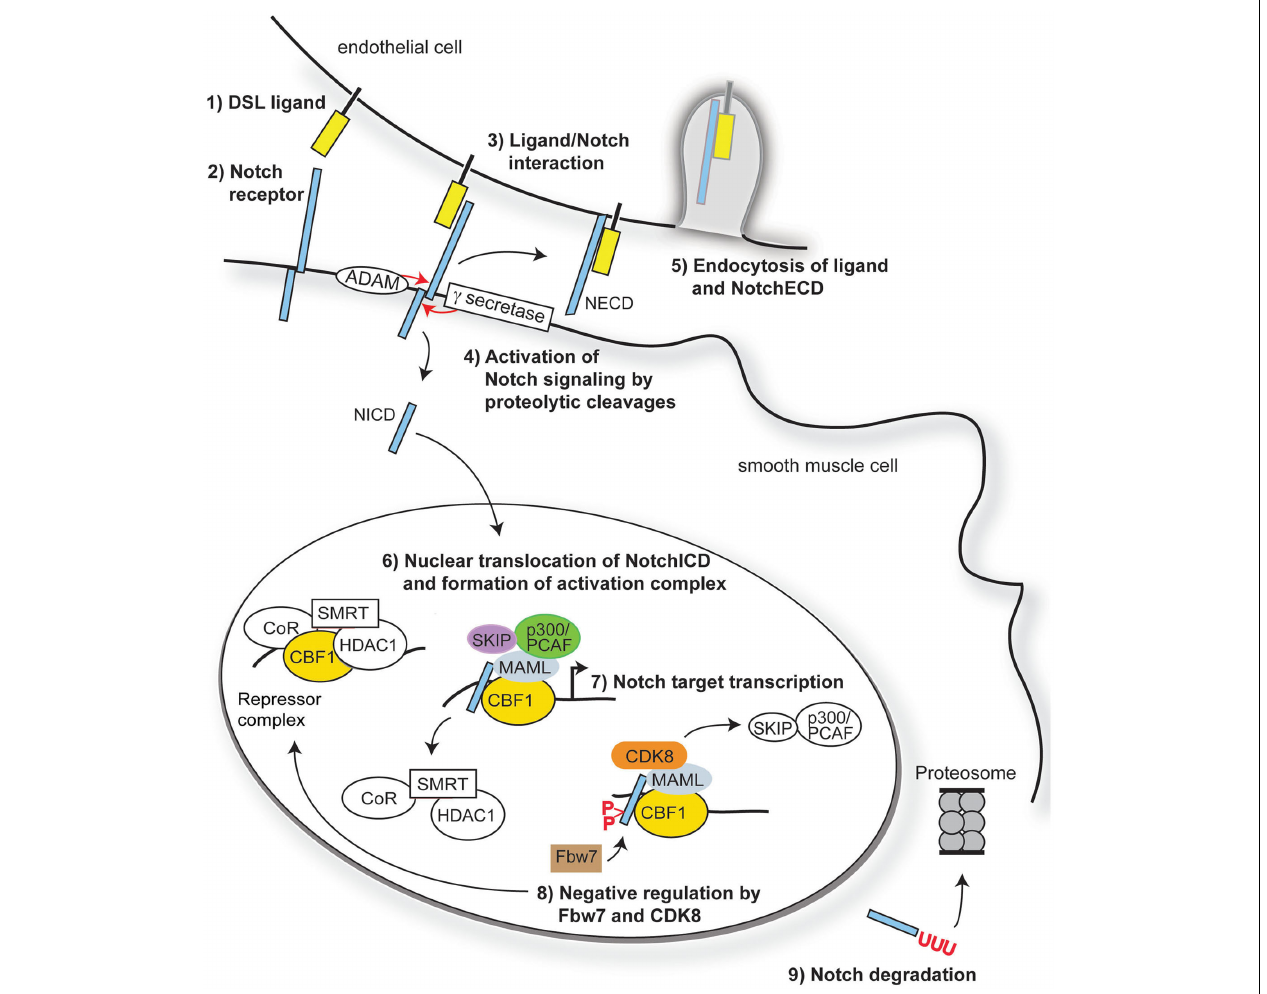
repressor CBF1, causing displacement of associated co-repressors and recruitment of Mastermind-like (MAML) and other co-activators (6) to initiate transcription of Notch/CBF1 regulated downstream genes (7).Turning off Notch signaling begins with recruitment of CDK8 by MAML to the active complex, thereby causing phosphorylation of NotchICD within its PEST domain. Phosphorylation causes recruitment of E3 ubiquitin ligase Fbw7 for ubiquitination (8) and proteosome degradation of (9) of NotchICD, thereby destabilizing the activator complex and allowing CBF1 to re-associate with